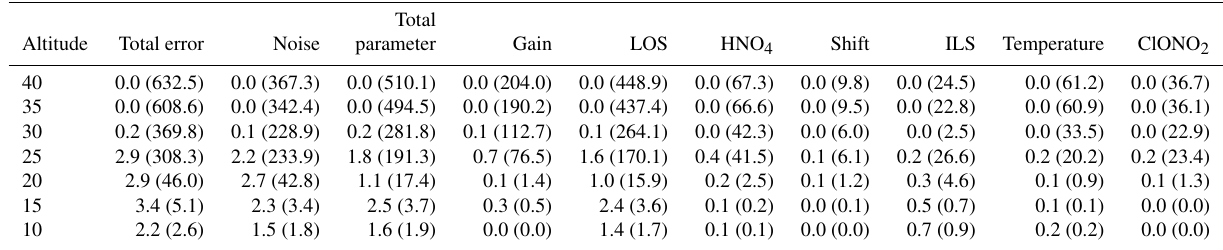
Table A6. Error estimates for a polar winter profile during the RR period. Errors are given in pptv (relative errors in %). Total Altitude Total